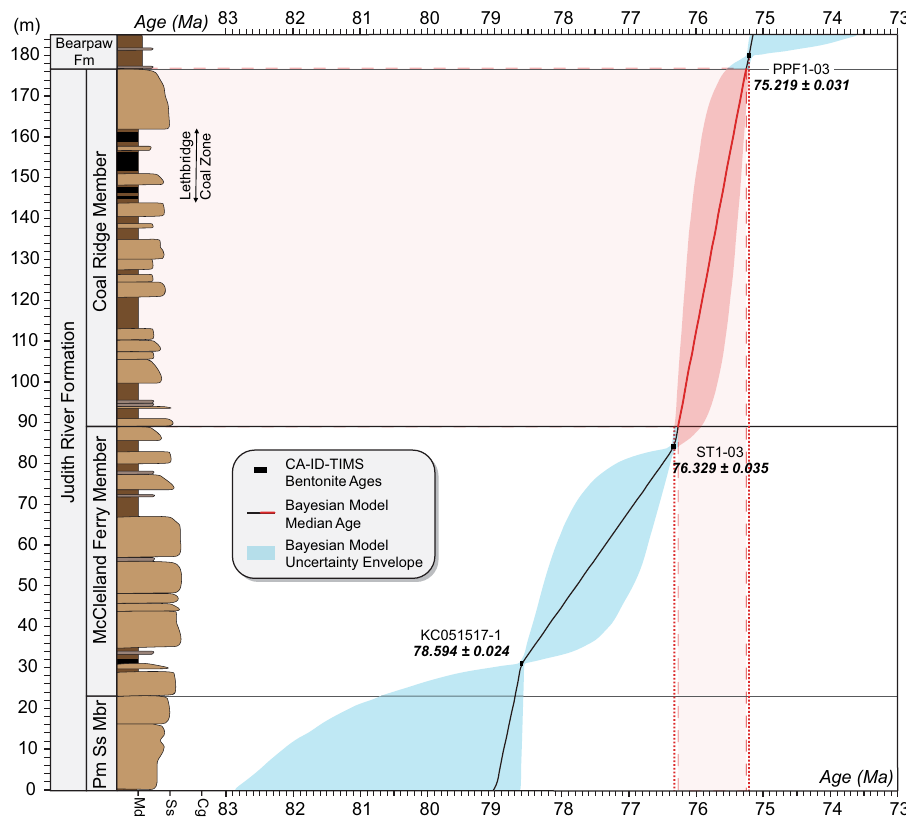
Figure 5. Lithostratigraphy (after Rogers et al. 83 ), U–Pb geochronology and Bayesian age-stratigraphic model for the Judith River Formation in its type area. Pm Ss Mbr, Parkman Sandstone Member. Red shading corresponds to the principal fossil-bearing interval and its model age, dotted lines incorporate the model age uncertainties. Note that the single U–Pb age from Kennedy Coulee (KC051517-1) has been projected onto the type stratigraphy (see text for